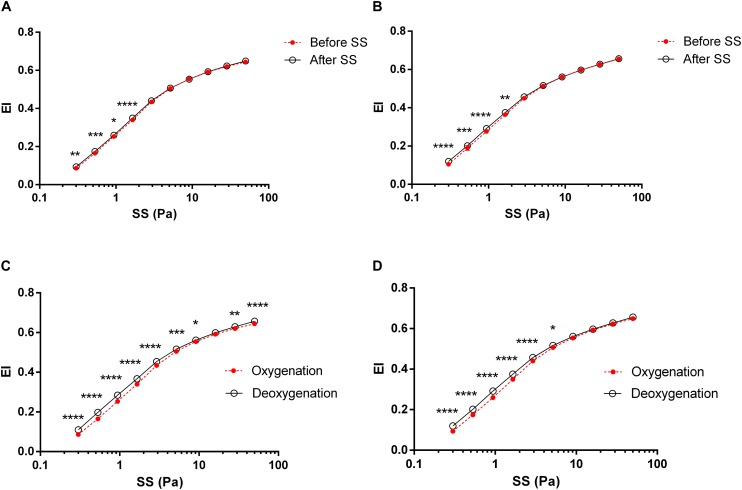
RBC deformability curves obtained by the change in elongation index (EI) versus shear stress (SS). Each circle represents an EI value corresponding to a different SS level (0.3, 0.53, 0.94, 1.65, 2.91, 5.15, 9.09, 16.04, 28.32, and 50 Pa). Data is collected from 10 different subjects with two replicative measurements and presented as mean ± standard error (SE). (A) The change in EI before and after 5 Pa SS in oxygenated conditions, (B) The change in EI before and after 5 Pa SS in deoxygenated conditions, (C) EI difference between oxygenation and deoxygenation before 5 Pa SS, (D) EI difference between oxygenation and deoxygenation after 5 Pa SS. ****p < 0.0001, ∗∗∗p < 0.001, ∗∗p < 0.01, ∗p < 0.05.